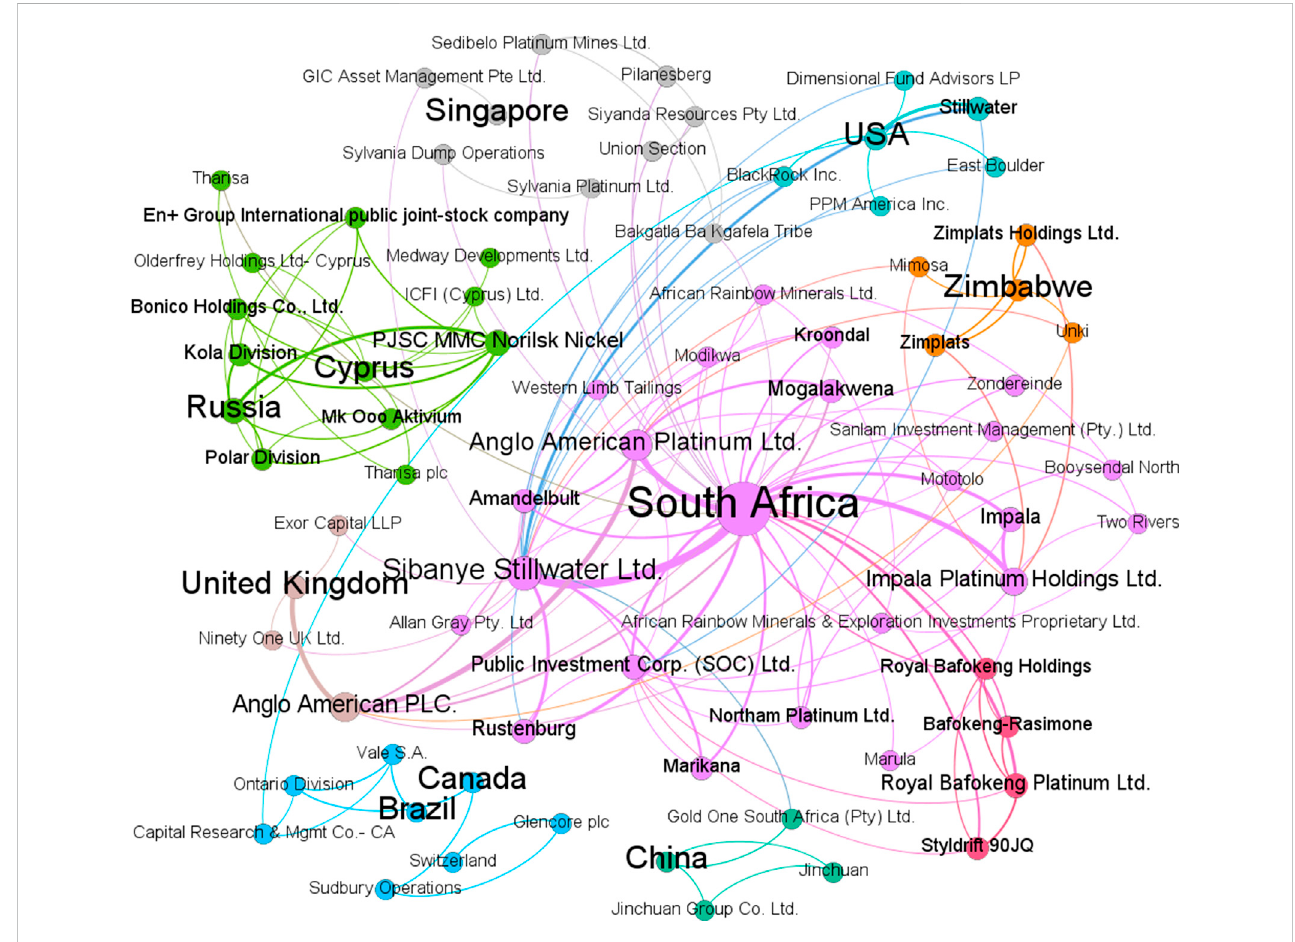
The global platinum supply network